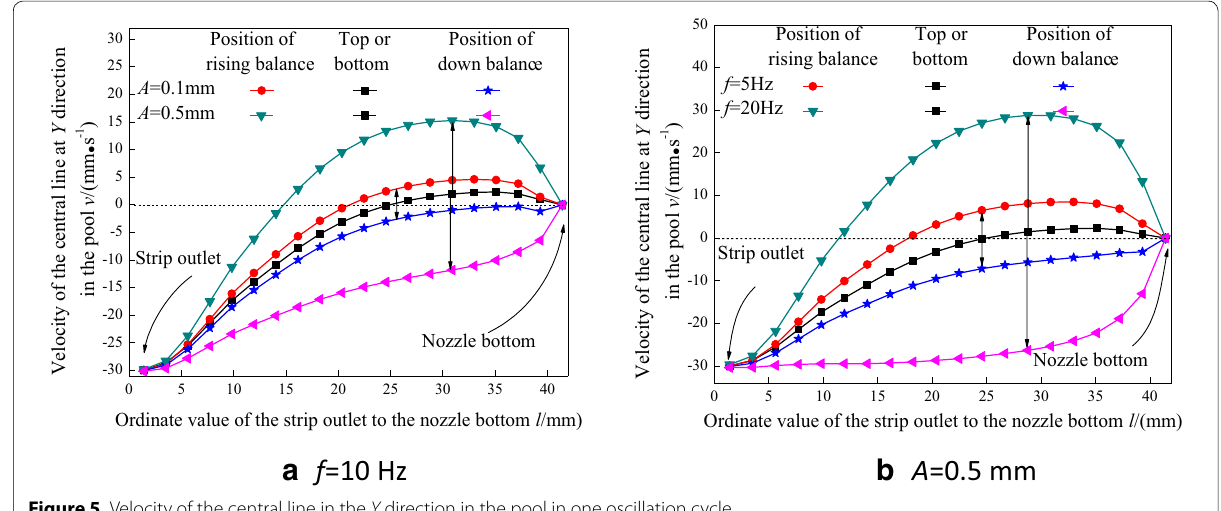
Figure 5 Velocity of the central line in the Y direction in the pool in one oscillation cycle